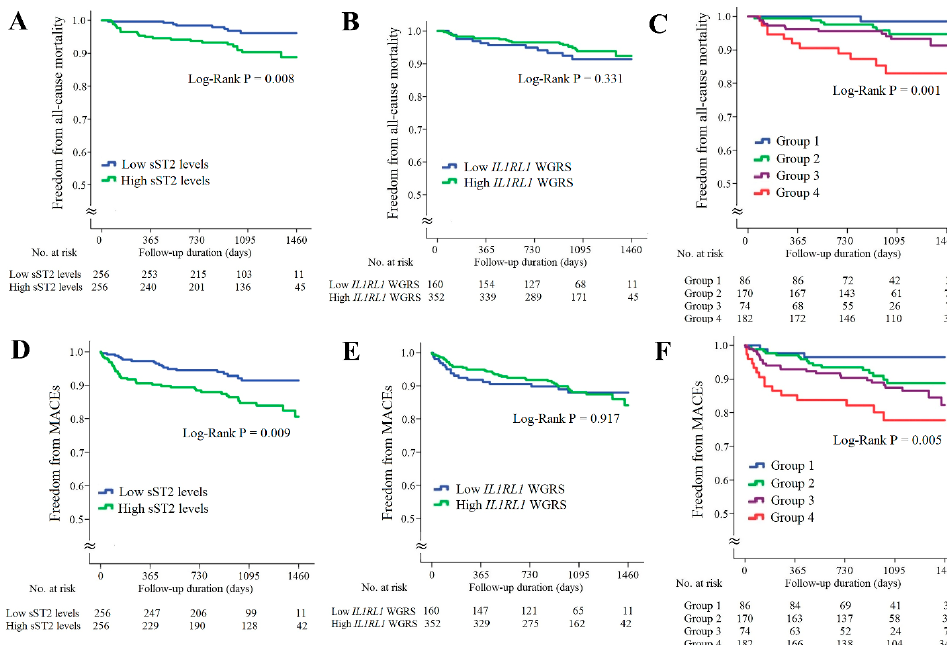
Figure 4. Kaplan–Meier curve analysis of sST2 levels and IL1RL1 WGRS with long-term outcomes in the patients with CAD. ( A – C ) Freedom from all-cause mortality in patients stratified by sST2 levels, IL1RL1 WGRS, and combination of sST2 levels and IL1RL1 WGRS. ( D – F ) Freedom from MACEs in patients stratified by sST2 levels, IL1RL1 WGRS, and combination of sST2 levels and IL1RL1 WGRS. WGRS, weighted genetic risk scores; MACEs, major adverse cardiac events. Group 1: low sST2 levels/low IL1RL1 WGRS; Group 2: low sST2 levels/high IL1RL1 WGRS; Group 3: high sST2 levels/high IL1RL1 WGRS; Group 4: high sST2 levels/low IL1RL1 WGRS.